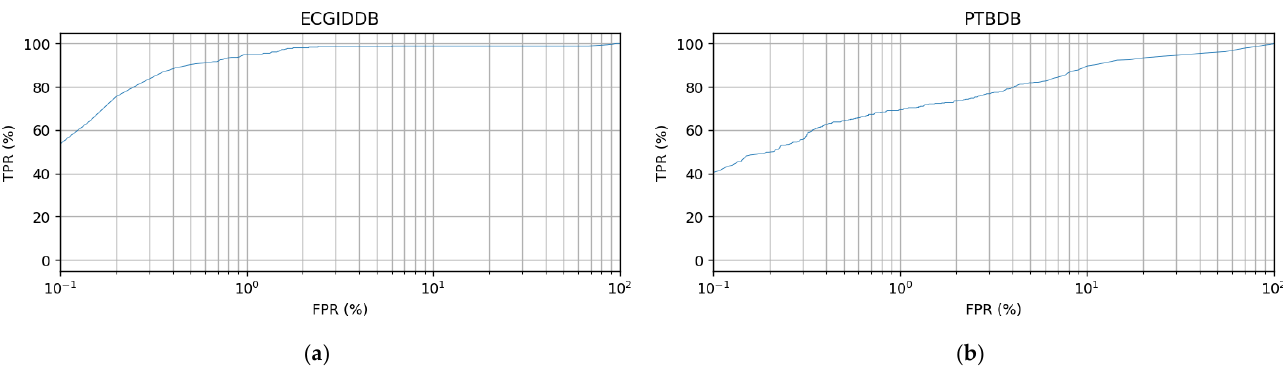
Figure A3. ROC curves are used to evaluate the individual verification performance tested over long time separation for: ( a ) ECGIDDB, ( b ) PTBDB.